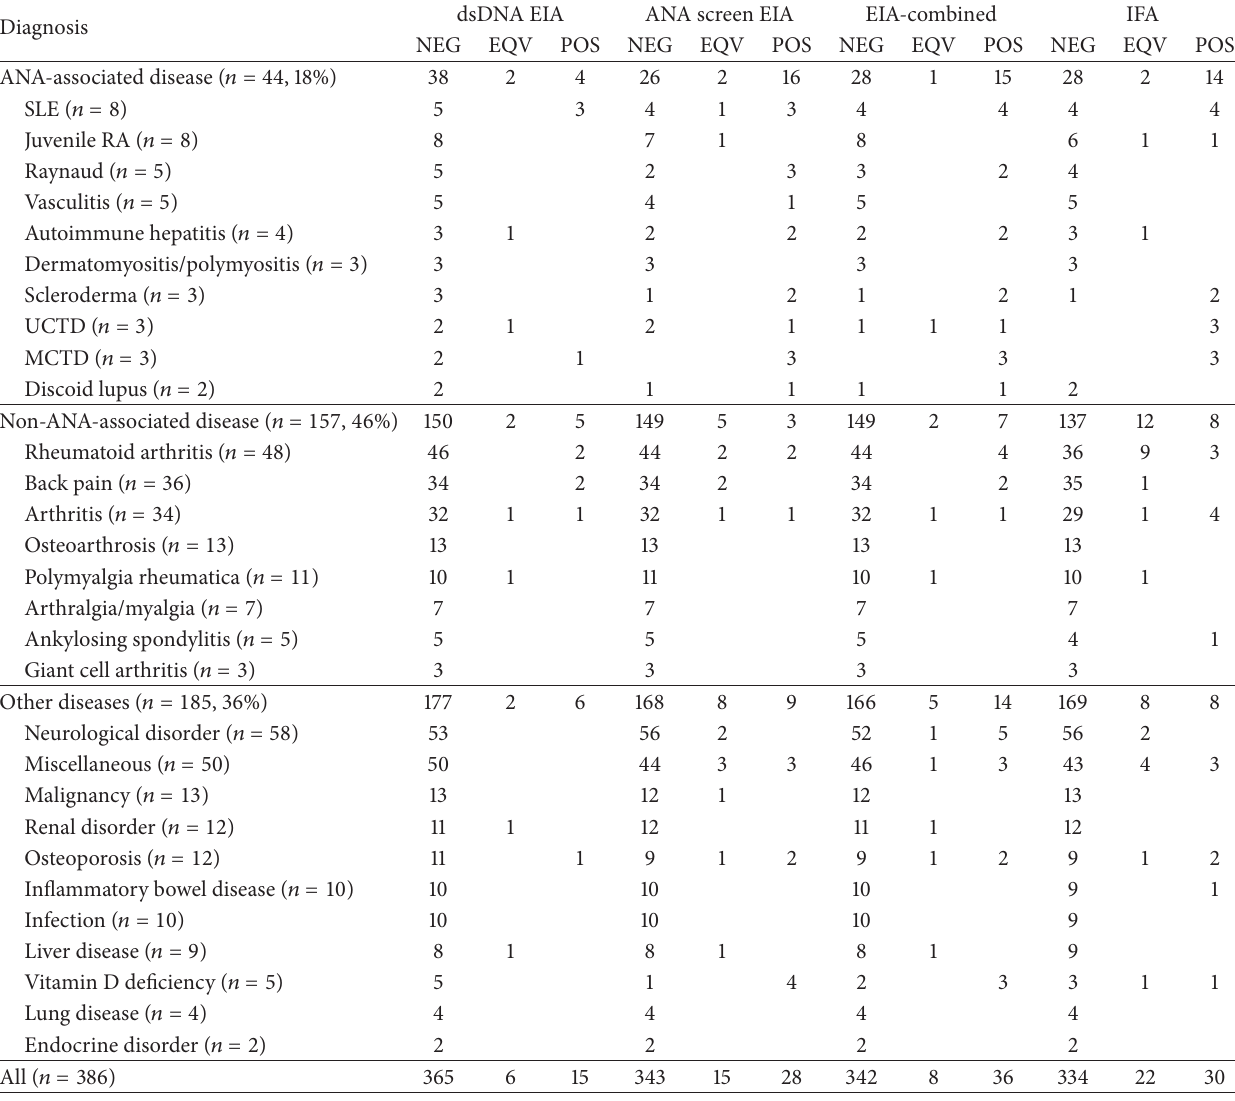
Table 1: Clinical diagnoses and results of EIA and IFA. The combined results of anti-dsDNA, ANA screening, and the seven individual antigens are referred to as “EIA-combined.” The IFA classification was based on the results from the primary laboratory and (if performed) from the secondary